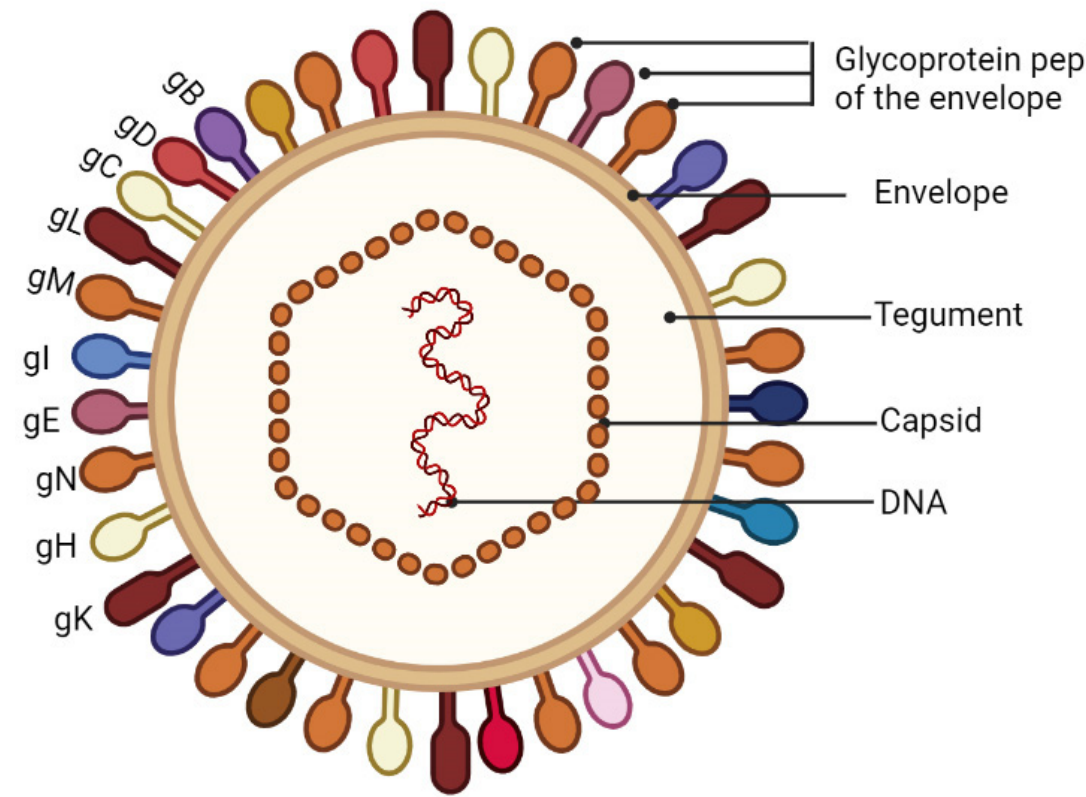
Figure 1. Schematic diagram of the PRV virion. PRV virions are composed of four structural elements, including a linear double-stranded DNA genome, an icosahedral protein capsid, a protein tegument layer, and a lipid envelope containing viral glycoproteins.